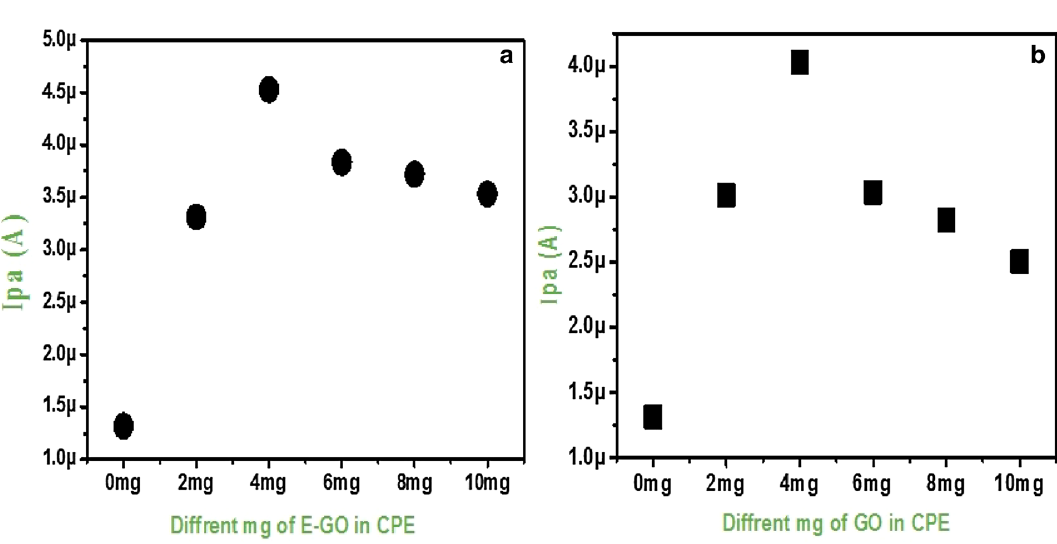
Figure 3. Graph of Ipa vs quantity of ( a ) GO and ( b ) E-GO in carbon paste